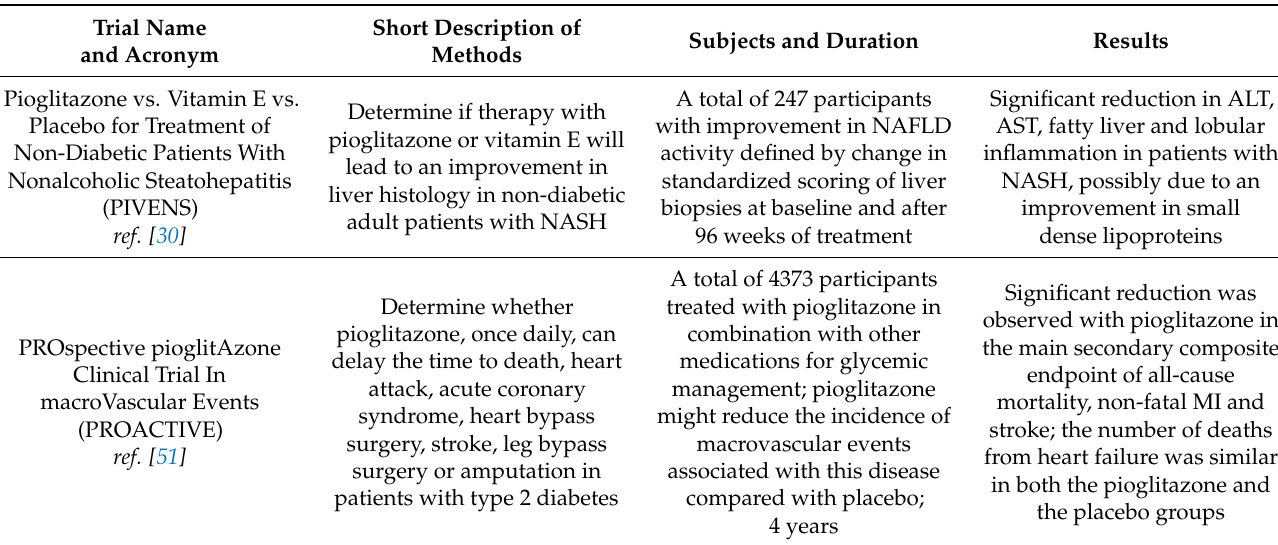
Table 1. Summary of landmark clinical studies involving